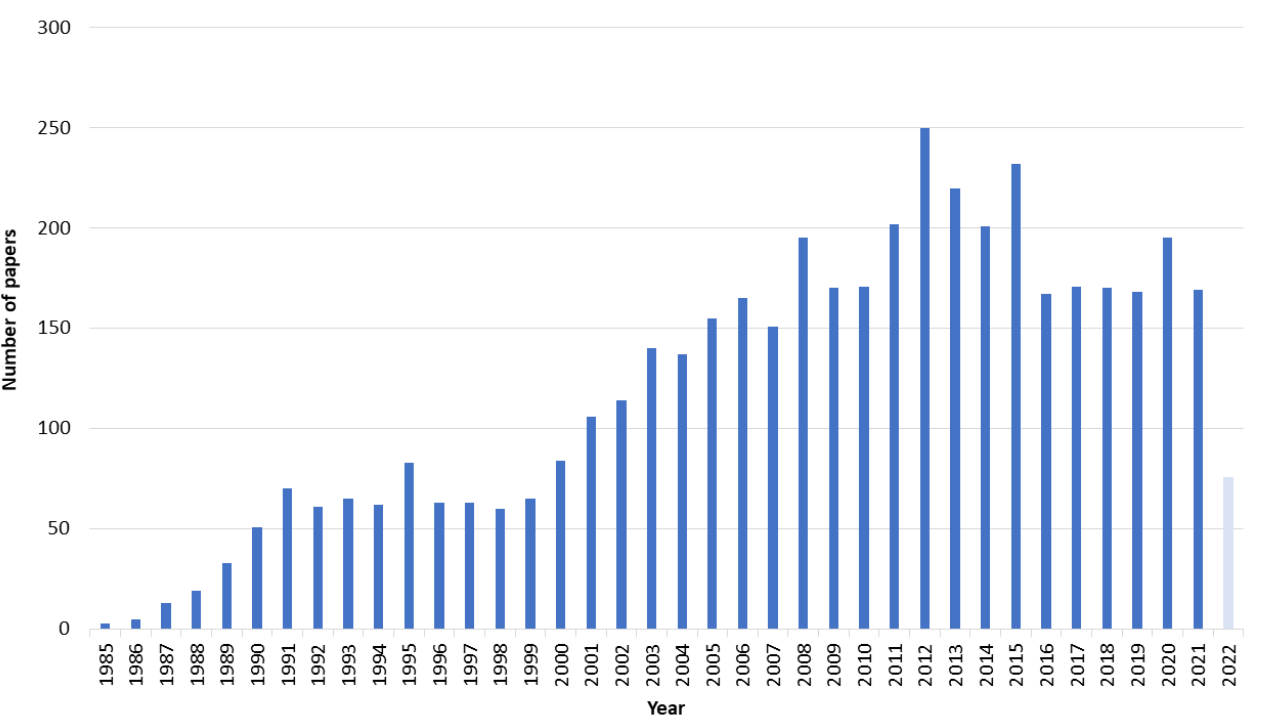
Figure 1. Number of papers retrieved by all 3 searches by year of publication (n = 4525).